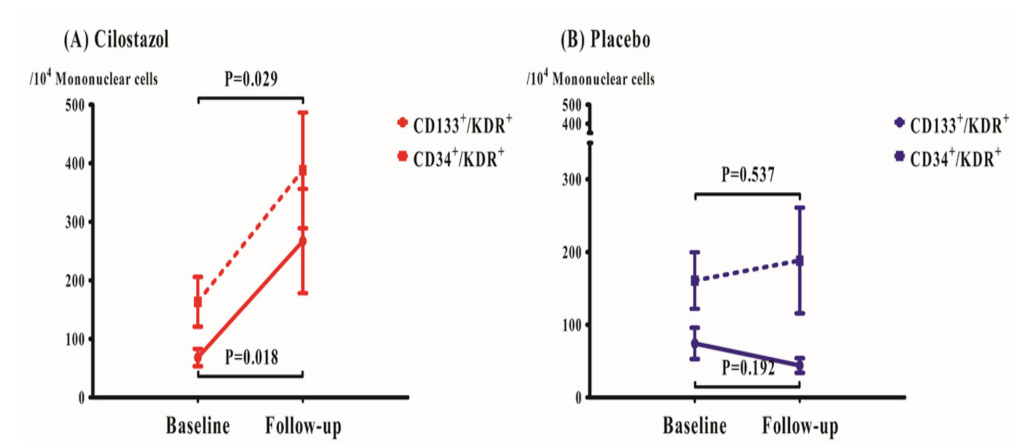
Figure 4. Changes of endothelial progenitor cell counts at baseline and 30-day follow-up. Cilostazol significantly increased both subsets of EPCs ( A ), whereas placebo had no significant e ff ect on EPC levels ( B ). Data are expressed as the mean percentage of cells positive for each marker ±